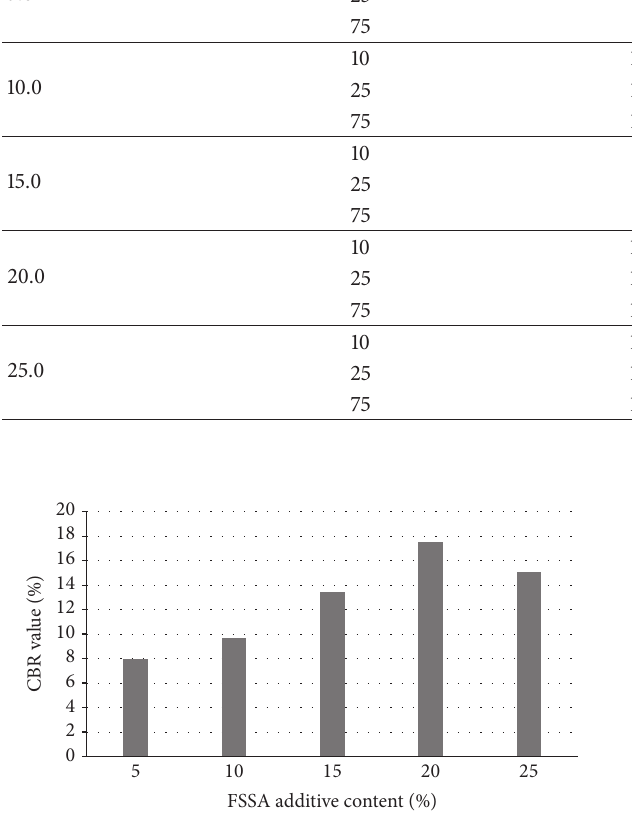
Figure 13: CBR values correspond to maximum dry density for FSSA additive